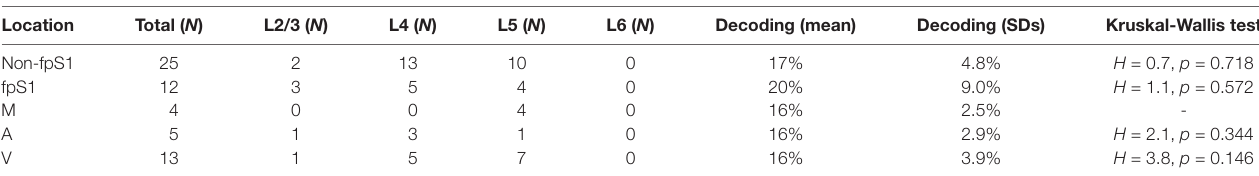
TABLE 1 | Statistical comparison of the decoding performance for neurons in different areas and layer.